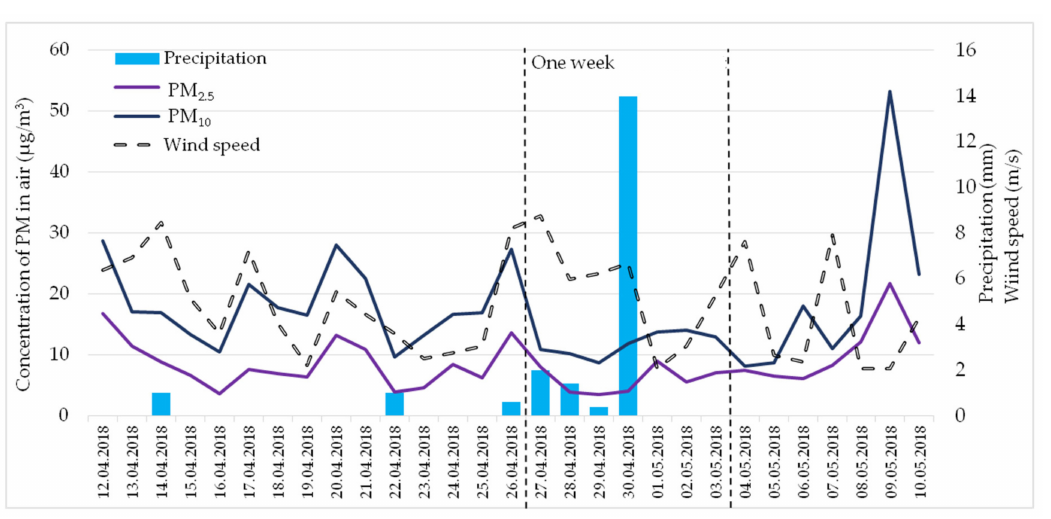
Figure 7. Meteorological conditions (rainfall and wind speed) and concentration of PM 10 and PM 2.5 during the five-week period. Dashed lines show the seven-day period subject to daily analysis. − 3 − 3 The air concentrations of PM 10 (from 8.2 µ g m to 53.2 µ g m ) were always higher than those of − 3 − 3 PM 2.5 (3.5 µ g m to 21.8 µ g m ), but both were a ff ected by the level of precipitation and, to